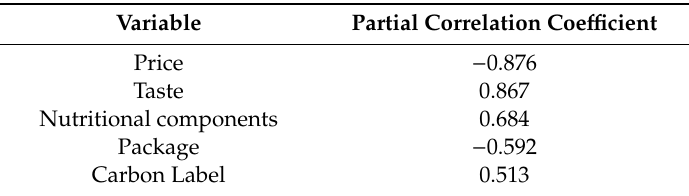
Table 5. Results of partial correlation analysis.